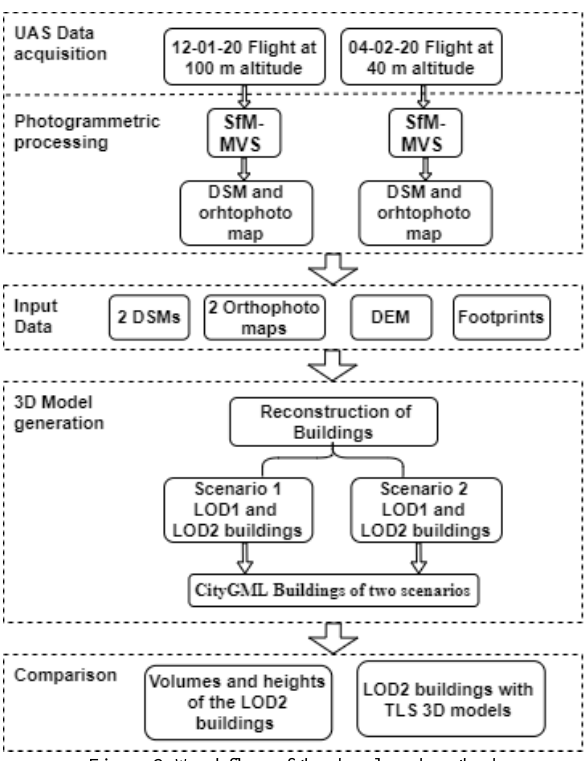
Figure 2. Workflow of the developed